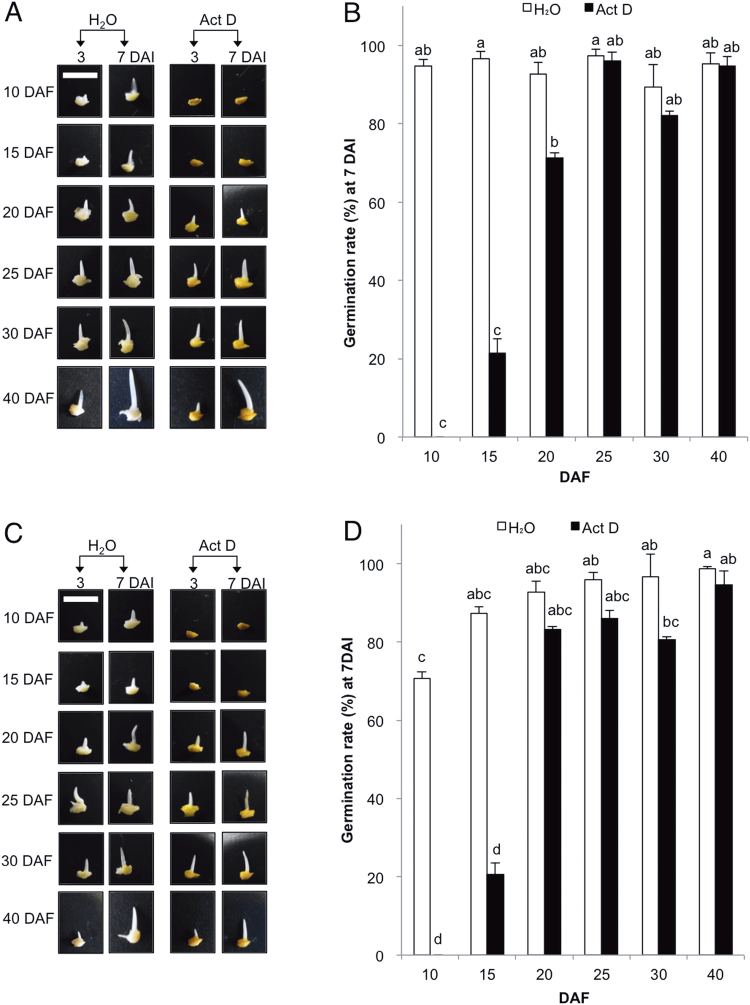
Inhibition of the germination of 10 and 15 DAF embryos by actinomycin D (Act D). Photographs show germination of developing embryos of Nipponbare (A) and Koshihikari (C) at 3 and 7 DAI with water in the presence or absence of Act D. Bar, 5mm. The germination rate values for Nipponbare (B) and Koshihikari (D) embryos are presented as the means ±SE of three replicates determined at 7 DAI with or without Act D. Identical letters represent significant difference at P<0.01 (Tukey–Kramer test).